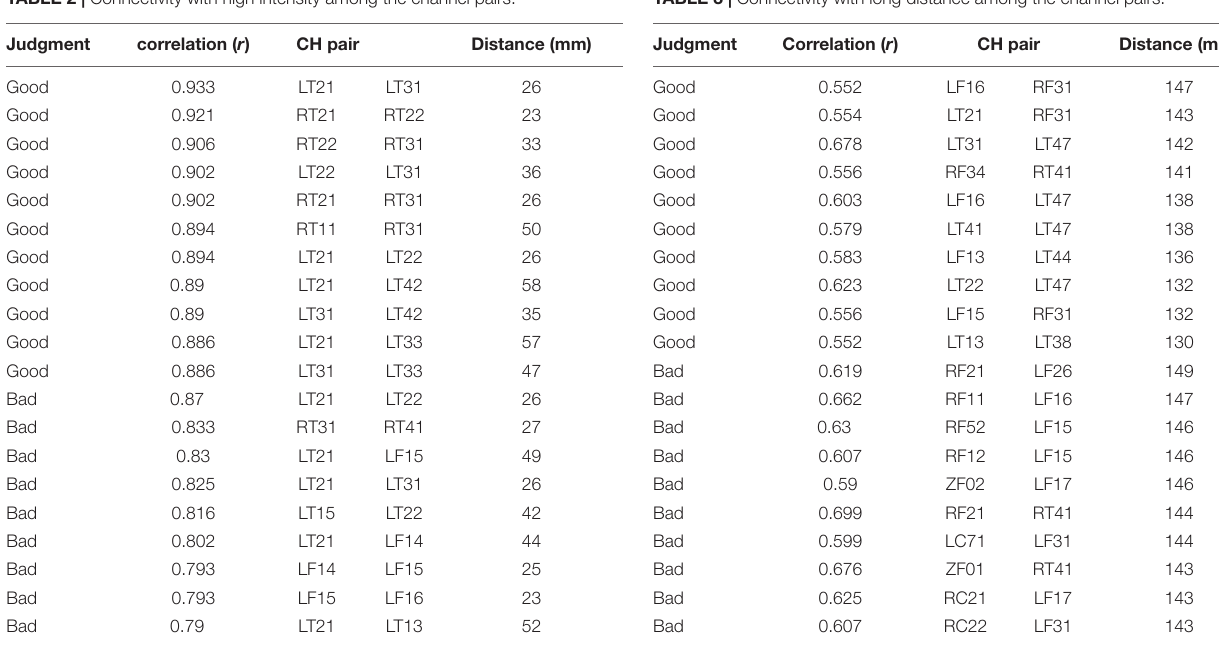
TABLE 2 | Connectivity with high intensity among the channel pairs. TABLE 3 | Connectivity with long distance among the channel